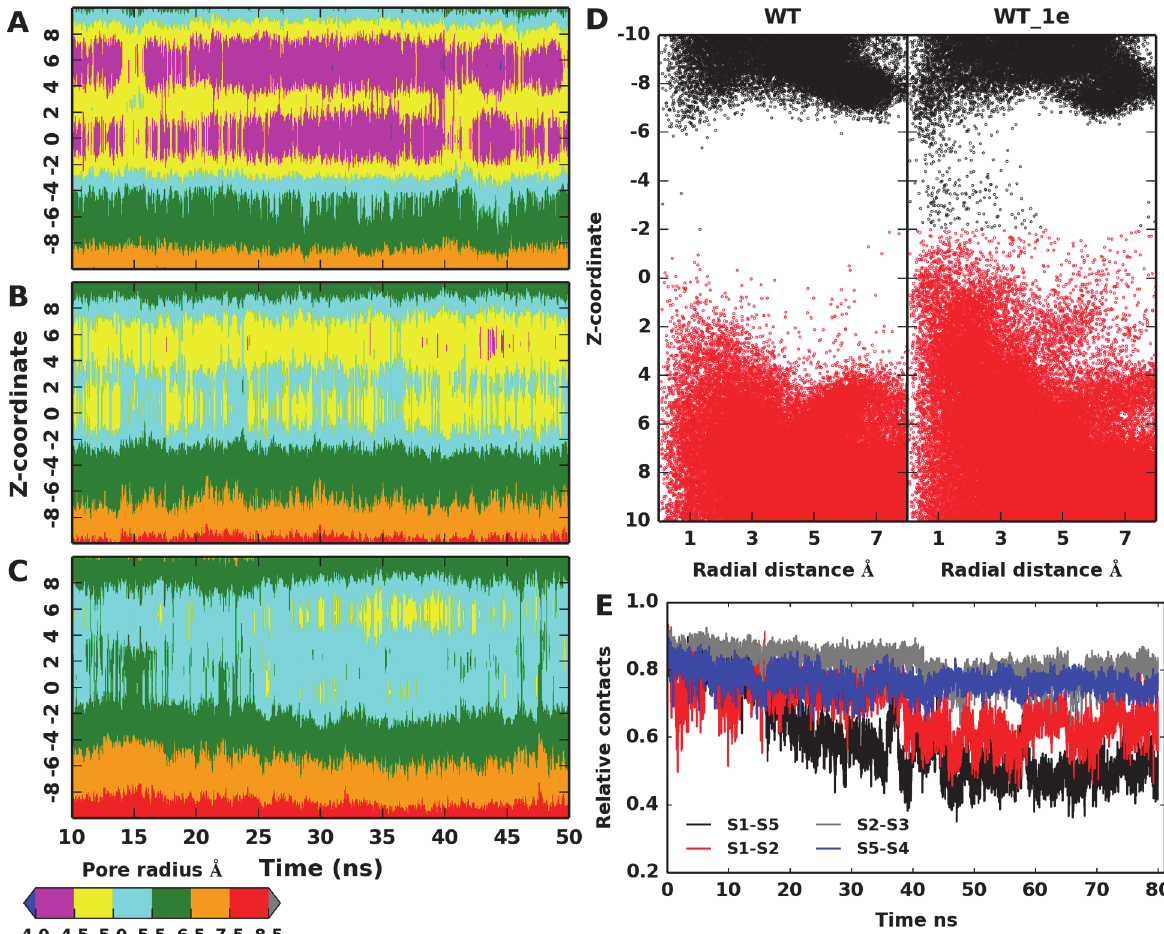
Fig 6. Pore radius, hydration along the channel and intersubunit contacts. Pore radius along the axial positions as a function of simulation time for (A) WT, (B) WT_1e and (C) NL models, obtained considering the backbone atoms. (D) Distribution of water molecules in the pore. For clarity, water molecules at the periplasmic vestibule of the pore are shown in black. (E) Inter-helix (TM1 vs TM1) contacts in WT_1e simulation relative to the starting configuration as a function of